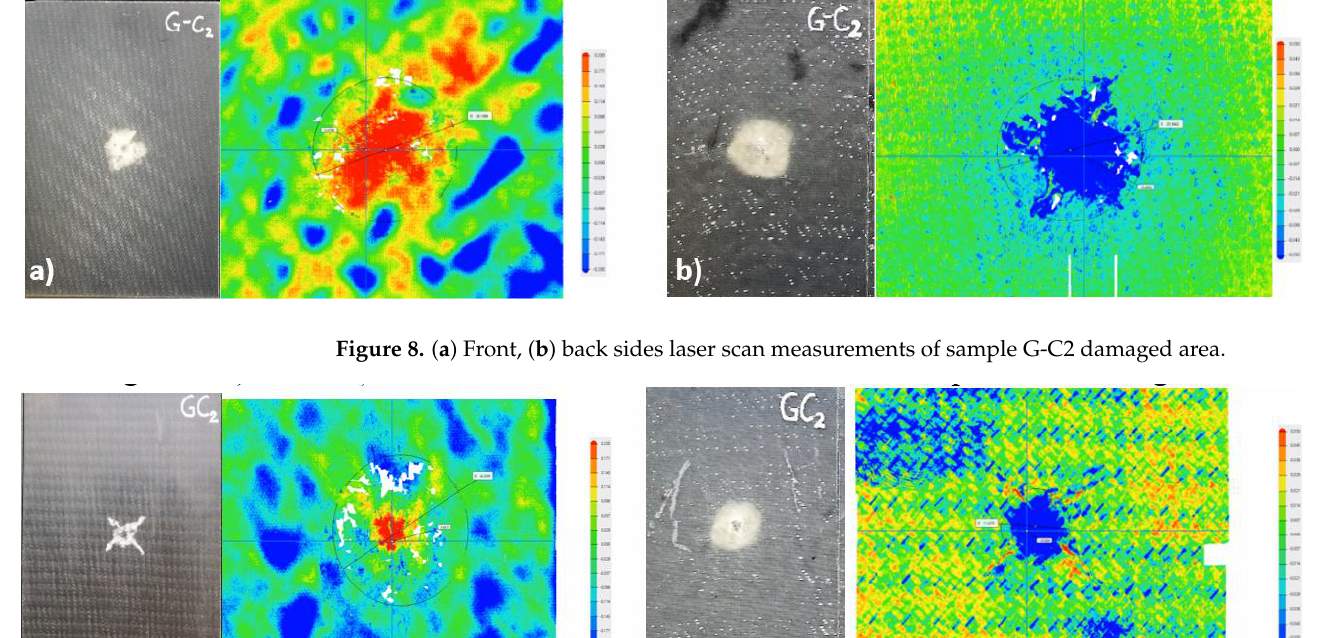
as representative samples by means of a 3D high resolution laser scanner.